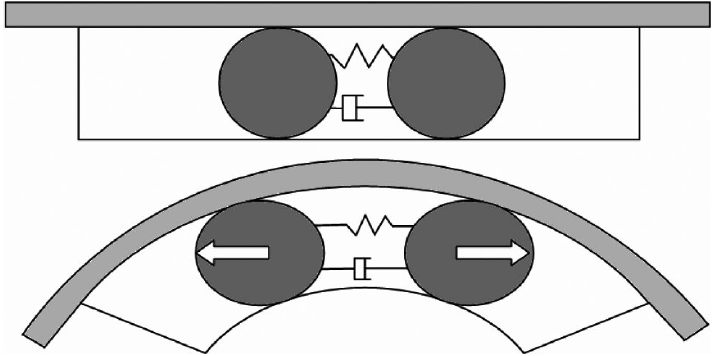
Fig. 54. Wave pressure generation in a